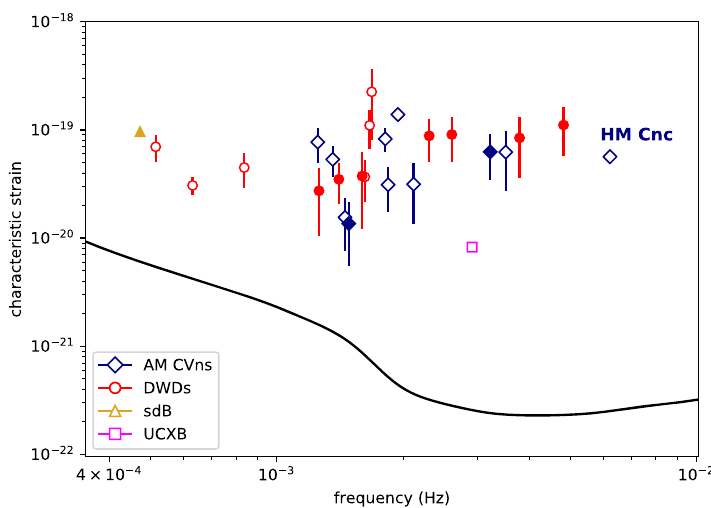
Fig. 2 Sensitivity plot for LISA assuming 10 year of observation with an 80% duty cycle showing the known binaries which reach a SNR (cid:7) 5. Filled symbols represent eclipsing sources and open symbols represent non-eclipsing sources from Kupfer et al. (2018). The black lack solid line represents the LISA sensitivity curve. Acronyms for binaries: AM Canum Venaticorum (AM CVns), WD ? WD (DWDs), subdwarf B-star (sdB) and ultracompact X-ray binary (UCXB). Image credit: Thomas Kupfer